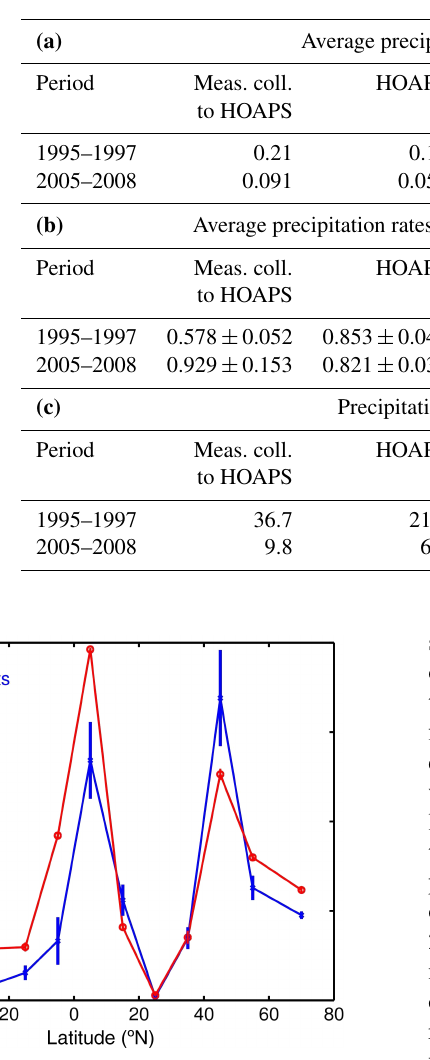
Table 1. Average precipitation rates (mmh − 1 ) of precipitation events (a) and average precipitation rates and their standard deviation (mmh − 1 ) for all collocated data pairs restricted to non-zero precipitation data (b) for collocated measurements and collocated HOAPS respective ERA-Interim data. In (c) , the precipitation frequencies (%) derived from all collocated data pairs of both data sets are shown.